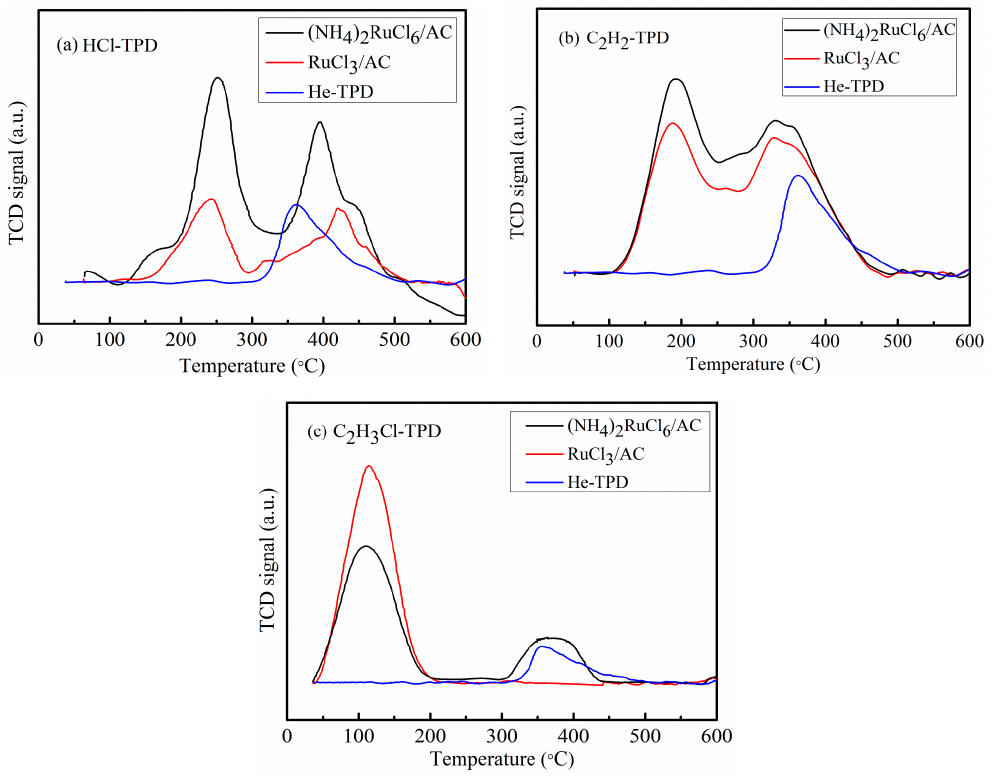
Figure 5. TPD of the fresh 1.0 wt % Ru ‐ based catalysts ( a ) HCl ‐ TPD; ( b ) C 2 H 2 ‐ TPD; ( c ) C 2 H 3 Cl ‐